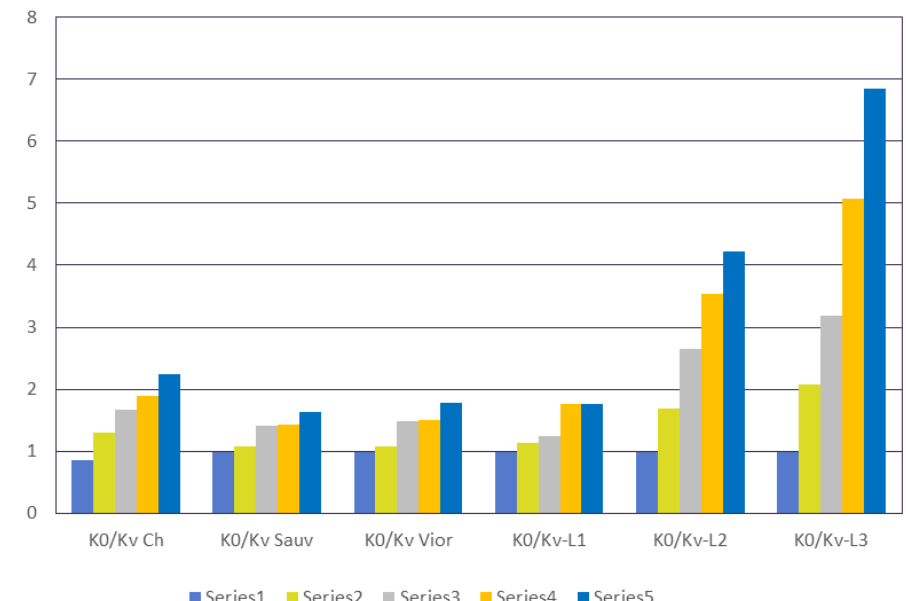
Figure 9. The comparative total antioxidant properties of Chardonnay, Sauvignon, Viorica, Legenda 1, Legenda 2 and Legenda 3 wines depending on their concentration in the reaction mixture, by reaction with crocin in the presence of radicals initiator AAPH. Series 1 – without wine supplements; Series 2-0.15 ml / 4 ml of reaction mixture; Series 3- 0.30 ml / 4 ml of reaction mixture, Series 4-0.45 ml / 4 ml of reaction mixture, Series 5-0,60 ml / 4 ml of the reaction